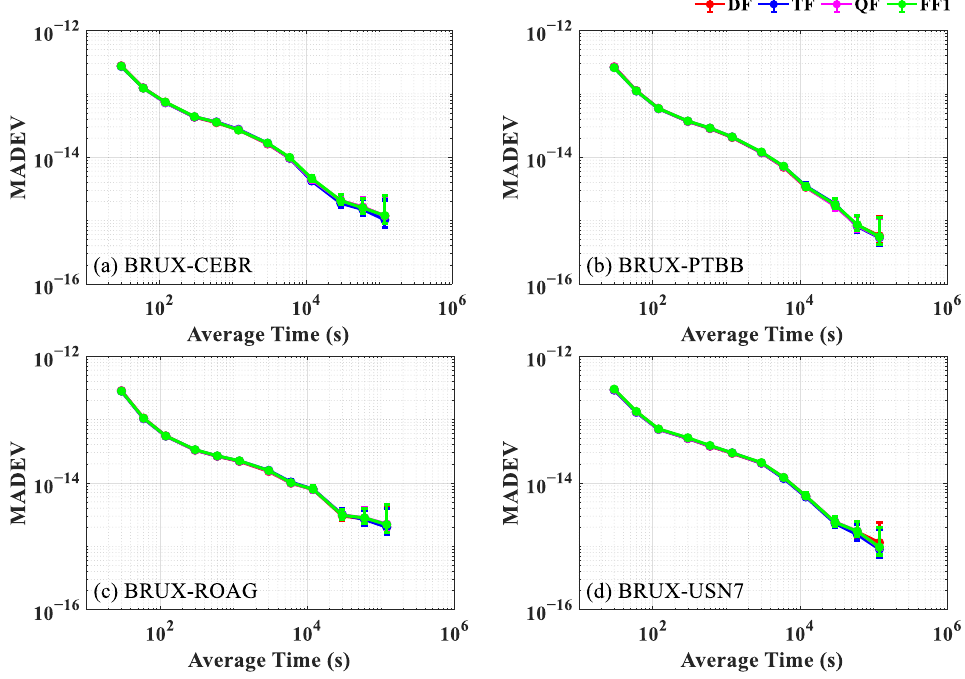
Figure 7. MADEV at four time-frequency links for the DF, TF, QF and FF1 PPP solutions on DOYs 190 to 196 in 2020. ( a ) BRUX-CEBR time-frequency link; ( b ) BRUX-PTBB time-frequency link; ( c ) BRUX-ROAG time-frequency link; and ( d ) BRUX-USN7 time-frequency link.